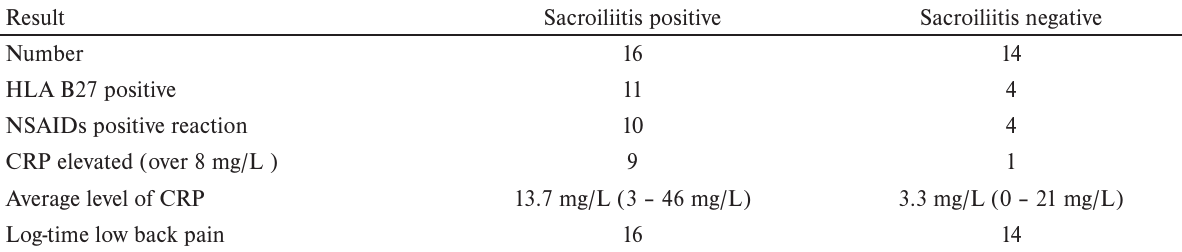
Table 2. Classification of our